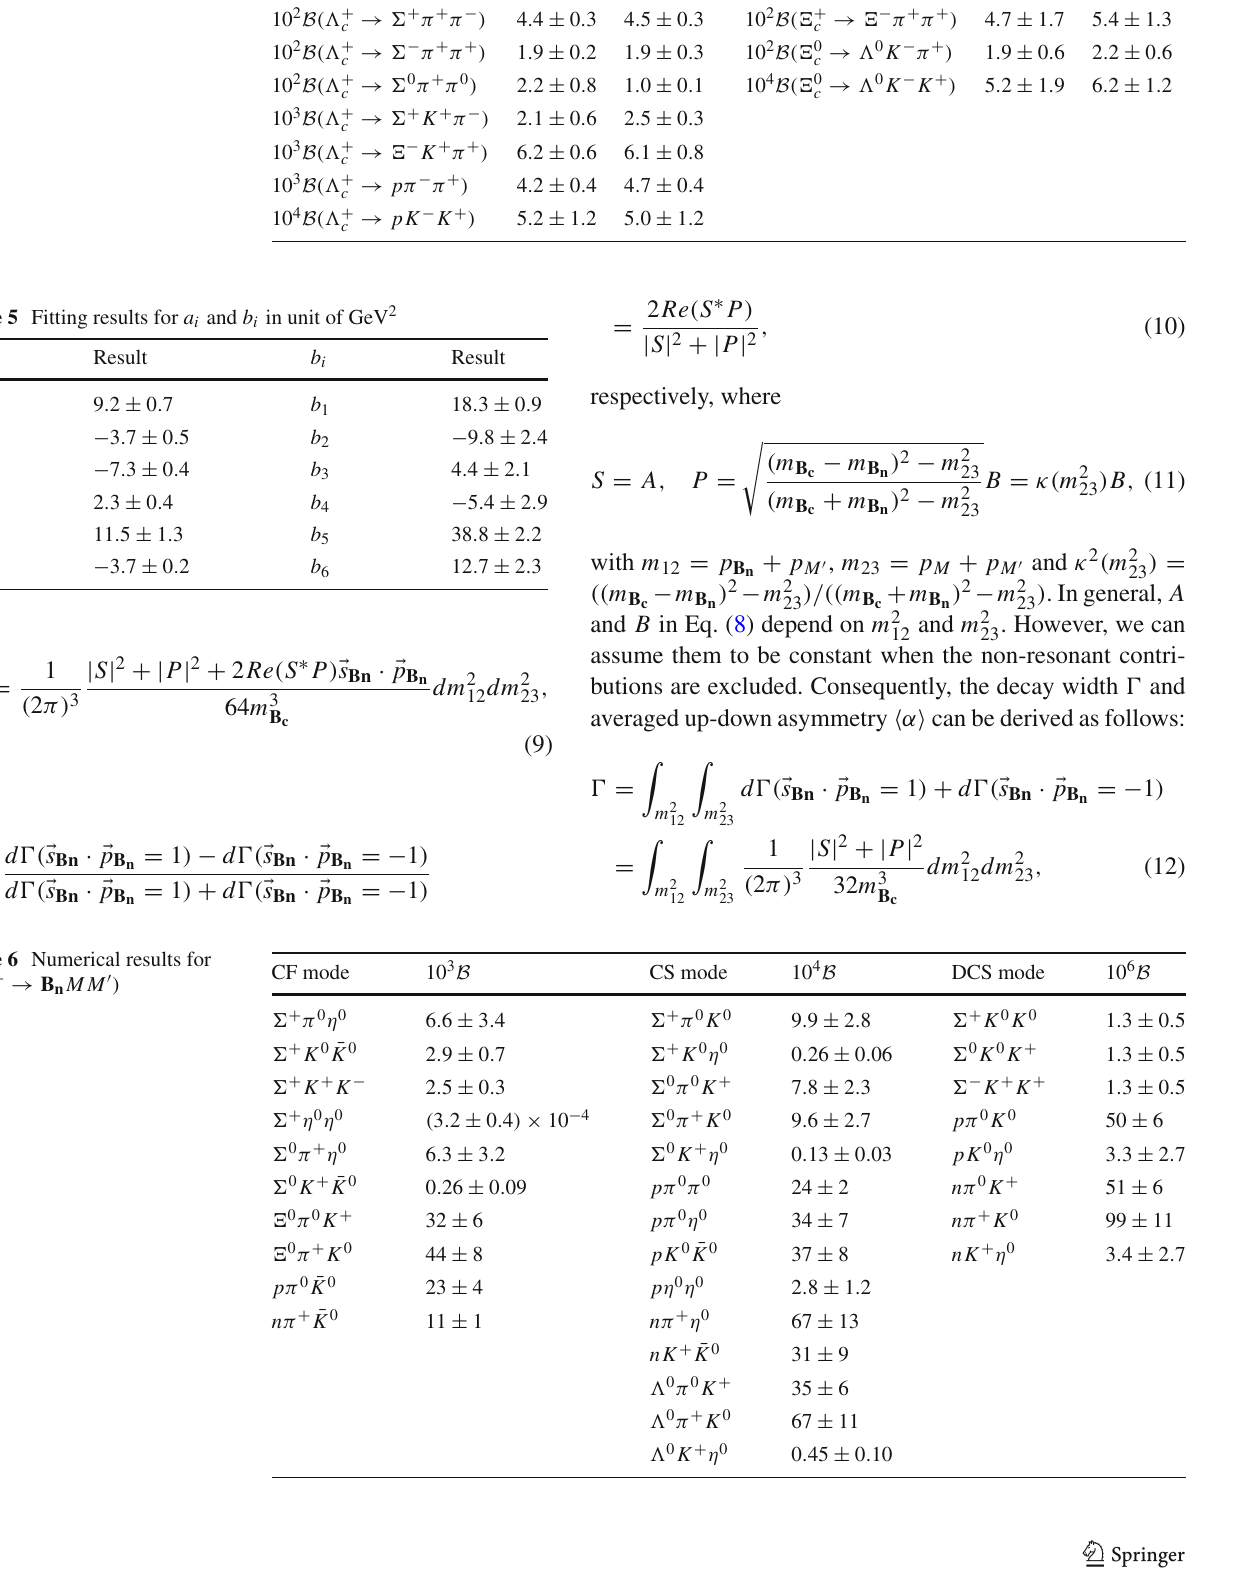
Table 4 The data inputs from Refs. [3,35–38] and reproductions for → B ) B ((cid:3) + n MM c